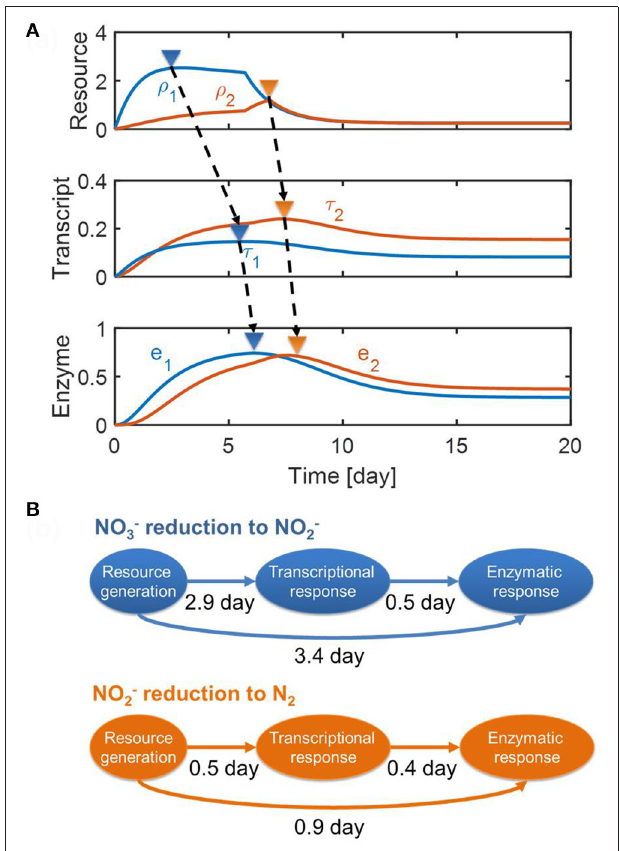
FIGURE 5 | Model predictions of (A) the dynamic changes in resources, transcripts and enzymes and (B) time delays from resource generation to transcriptional and enzymatic responses. In (A) , the upside-down triangles denote the time where each variable reaches its maximal